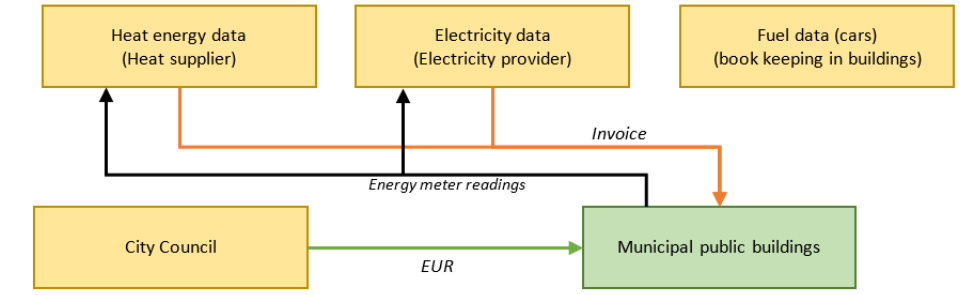
Fig. 4. Energy consumption data management system in Daugavpils municipal buildings before